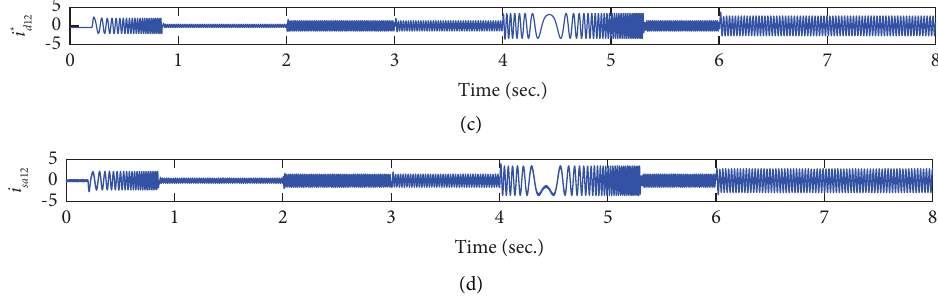
Figure 6: Motor current through inverter 2 showing reference current.